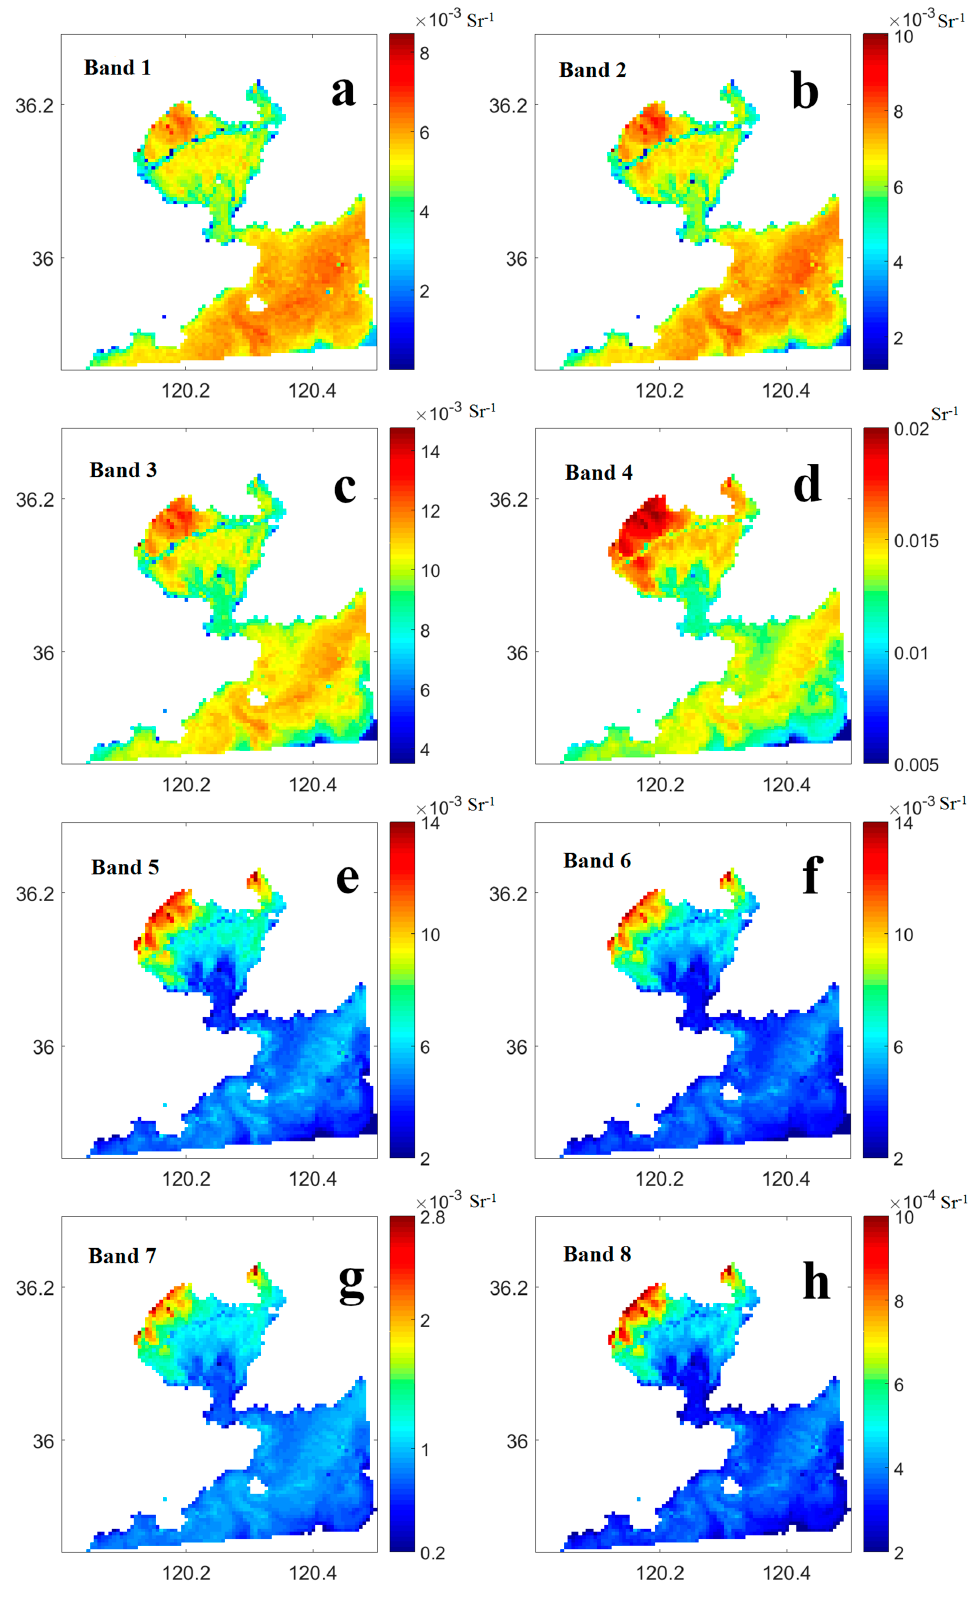
Figure 3. Distributions of Rrs for each pixel in the eight GOCI bands ( a – h ) following the order in Table 1) on 13 Sep 2017 in